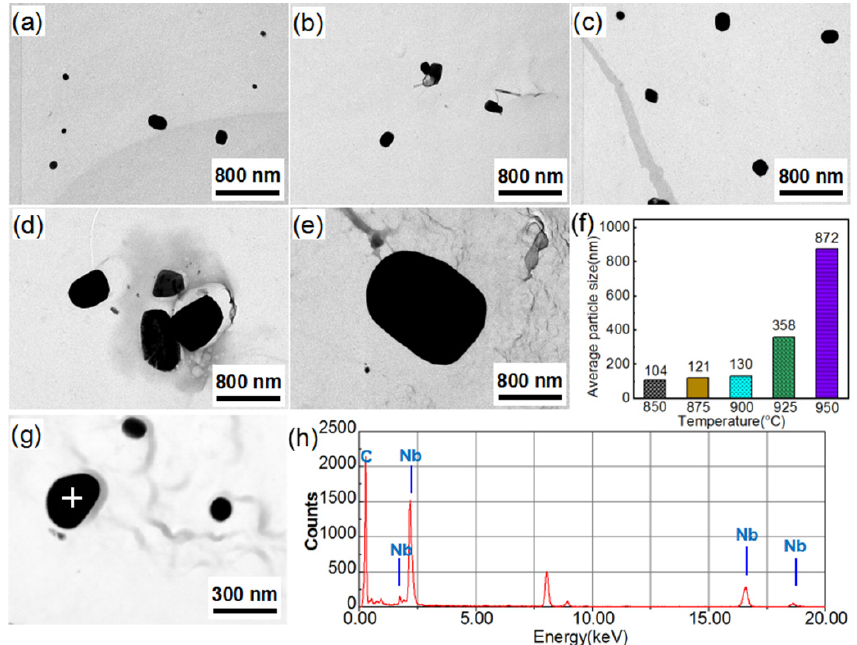
Figure 5. TEM micrographs of precipitates in annealed the Fe 81 Ga 19 thin sheet with increasing temperature: ( a ) 850 °C, ( b ) 875 °C, ( c ) 900 °C, ( d ) 925 °C, and ( e ) 950 °C. ( f ) The size distribution at different temperatures. ( g , h ) EDS of precipitates at 850 °C.